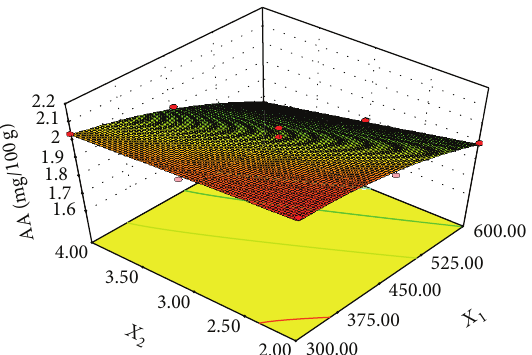
Figure 7: Effect of microwave power ( 𝑋 1 ) and pretreatment time ( 𝑋 2 ) on